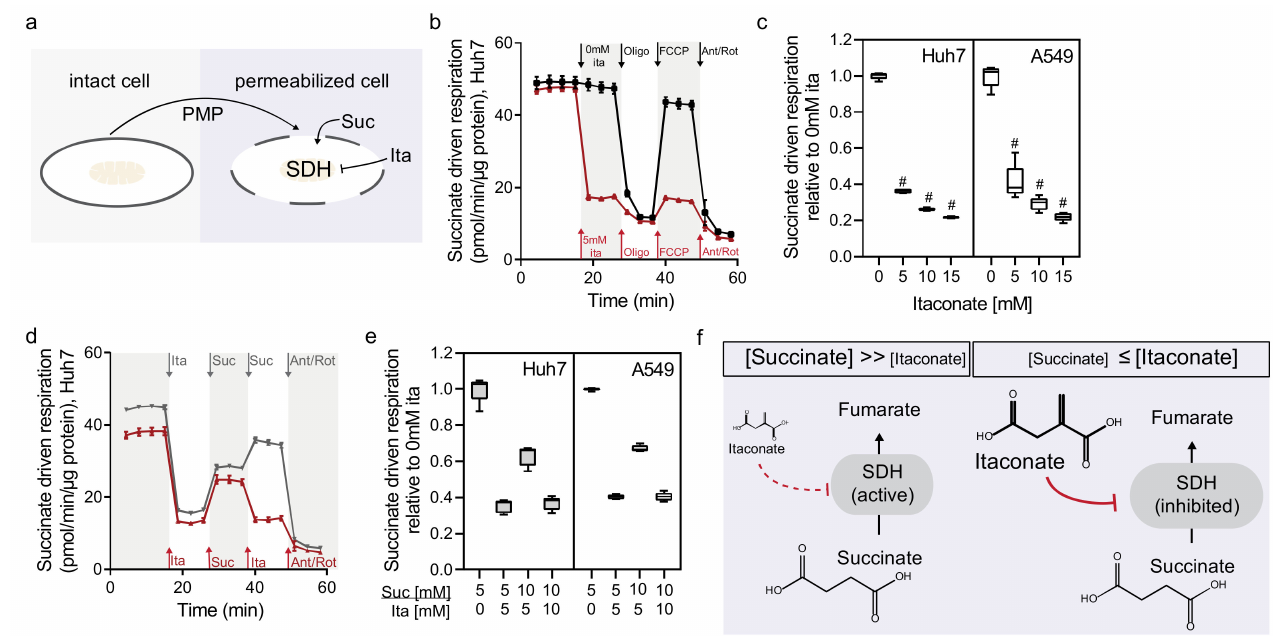
Figure 2. Itaconate is a competitive and reversible SDH inhibitor in diverse cell types. ( a ) Schematic depicting plasma membrane permeabilizer reagent (PMP) to access mitochondrial respiration in permeabilized cells. ( b ) Succinate-driven respiration in Huh7 cells in the presence (red) or absence (black) of itaconate (ita). ( c ) Succinate-driven respiration with increasing itaconate concentrations in Huh7 and A549 cells. Significance is depicted compared to 0 mM itaconate. ( d ) Succinate-driven respiration after serial addition of Ita/Suc/Ita (red) or Ita/Suc/Suc (grey) in HuH7 cells. ( e ) Succinate driven respiration after serial addition of itaconate or succinate in Huh7 and A549 cells. ( f ) Schematic depicting the competitive inhibition of itaconate on succinate dehydrogenase (SDH) activity. Data depict mean ± s.e.m. ( b , d ) or box and whiskers ( c , e ) obtained from 5 cellular replicates. One-way ANOVA (c) relative to 0 mM itaconate with no adjustment for multiple comparisons and # p <